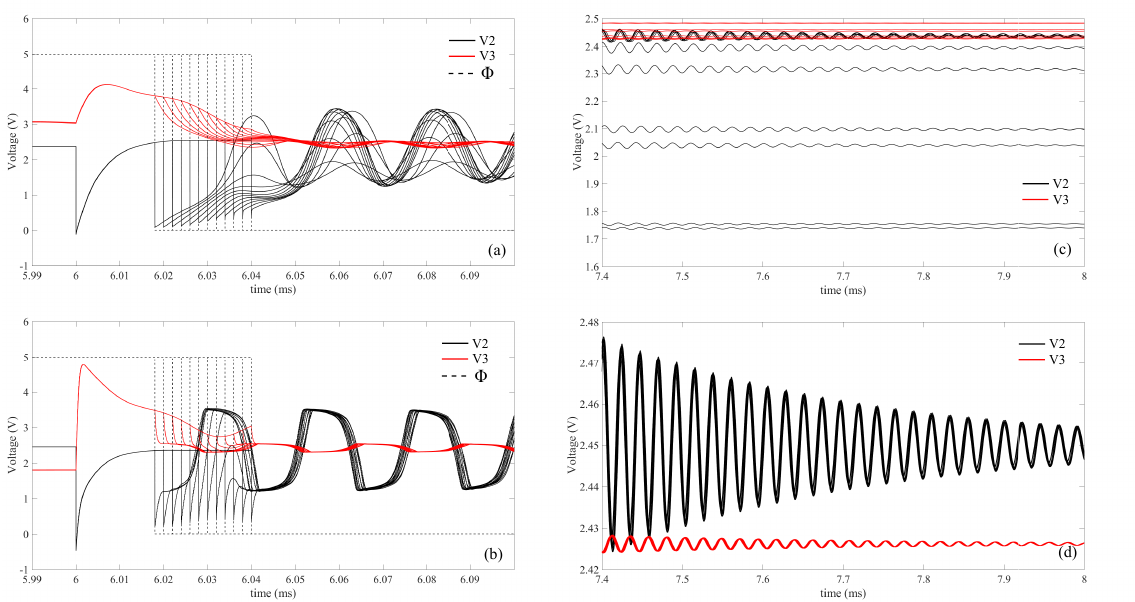
Figure 20. Analysis of the effects of the transition from actuation mode to read-out mode, for different values of T 2 . ( a ) analysis of the signals V 2 , V 3 immediately after the occurrence of the transition, with V 3 characterized by a slow dynamic; ( b ) analysis of the signals V 2 , V 3 immediately after the occurrence of the transition, with V 3 characterized by a fast dynamic; ( c ) analysis of the signals V 2 , V 3 after the oscillation has been almost completely damped, for the case shown in ( a ); ( d ) analysis of the signals V 2 , V 3 after the oscillation has been almost completely damped, for the case shown in ( b